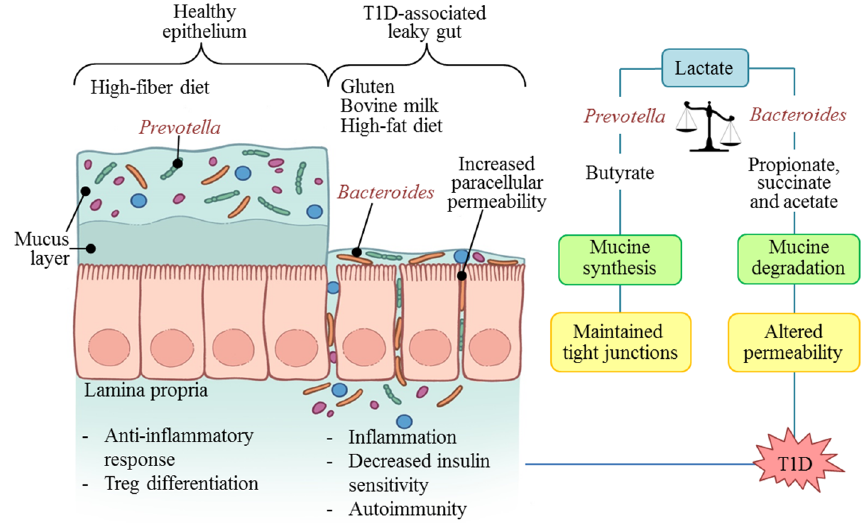
Figure 1. Diet and microbiota associated mechanisms in autoimmunity and type 1 diabetes Diet and microbiota associated mechanisms in autoimmunity and type 1 diabetes (T1D) development. (T1D)